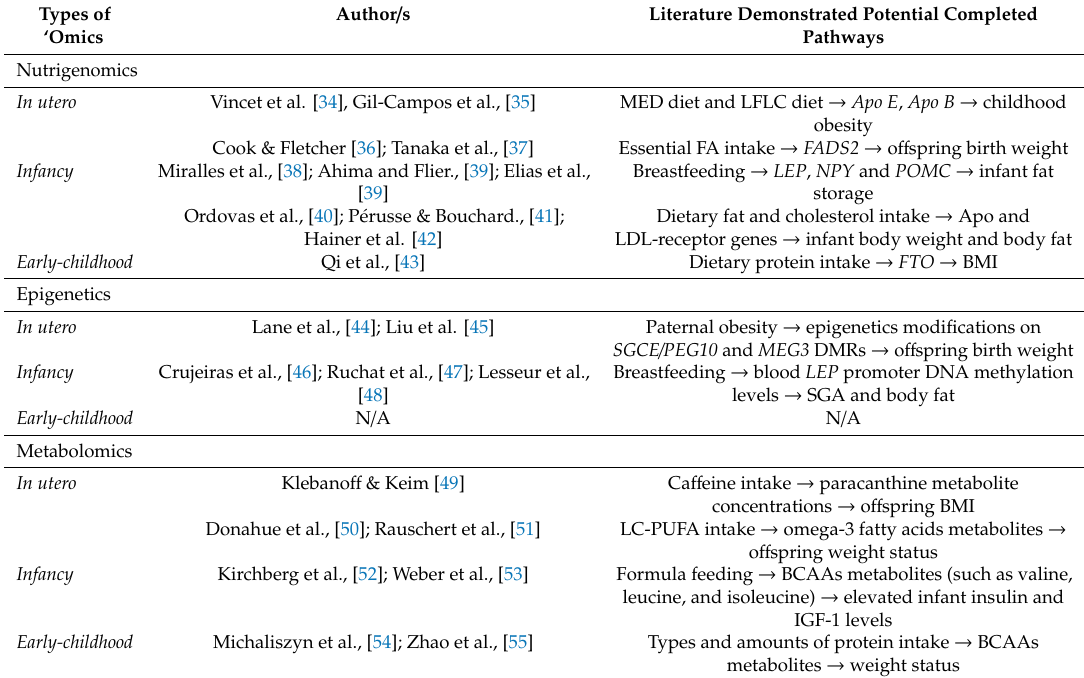
Table 1. Summary of studies that demonstrated potential completed nutrition, ‘omics, and childhood obesity risk